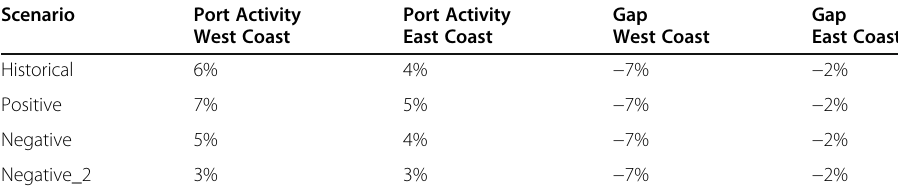
Table 7 Assumptions applied to the model Scenario